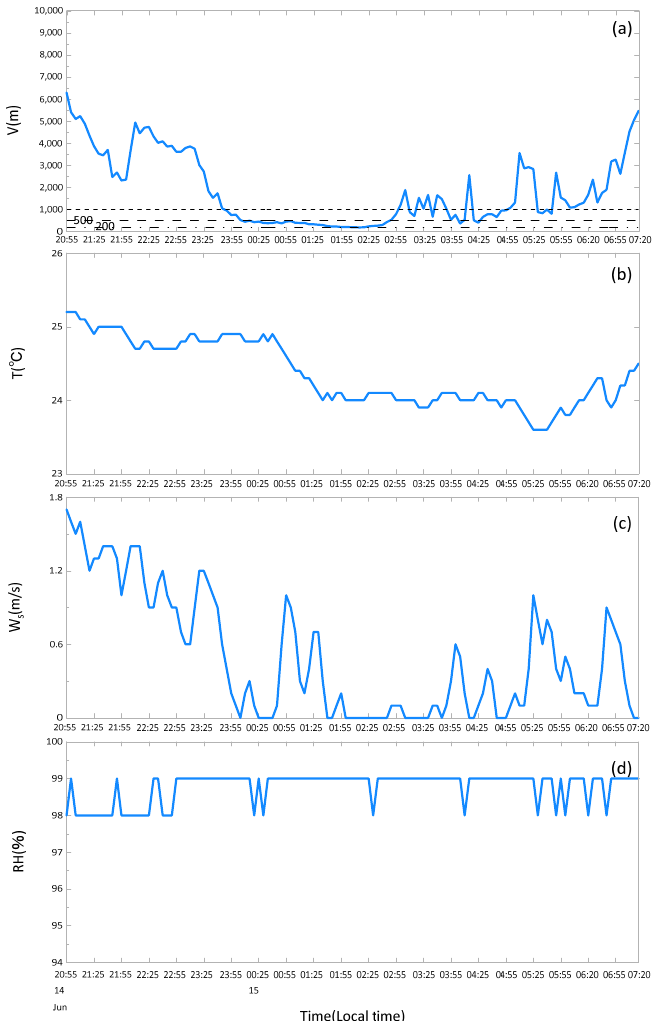
Figure 4. Example of the evolution of meteorological elements. The example time is 20:55 on 14 June to 7:20 on 15 June. ( a ) V, ( b ) T, ( c ) W S , ( d ) RH. The dotted lines represent 1000 m, 500 m, and 200 m (Figure 4a).